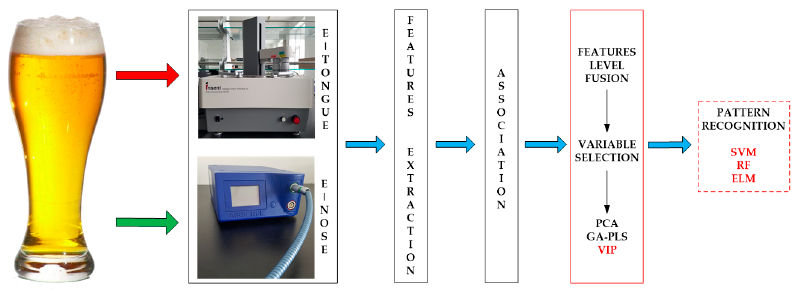
Figure 1. The graphical abstract for this paper.